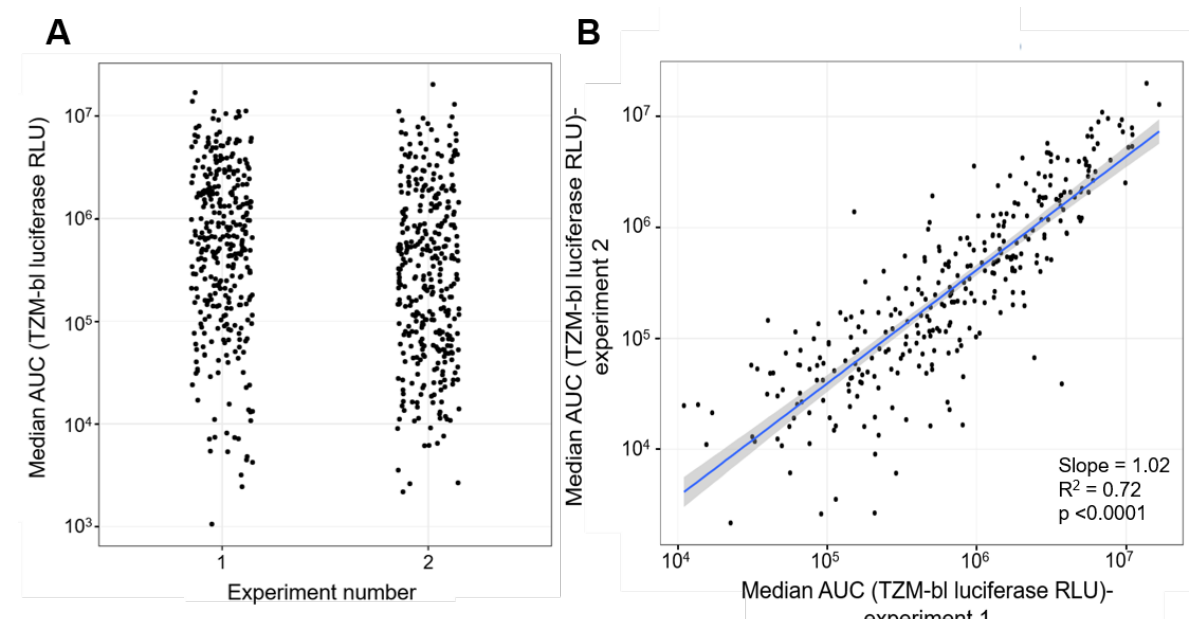
Figure 4. Comparison of replication capacities of 346 primary HIV-1 isolate obtained from two separate experiments. ( A ) Distribution of the replication capacities (AUC) of 346 primary HIV-1 isolates for each experiment. The x-axis denotes the experiment from which the AUC values were measured. The y-axis depicts the replication capacities of the primary HIV- 1 isolates represented as AUC values. ( B ) Scatterplot comparison of AUC values obtained from two separate experiments. The x-axis represents the values for the first experiment and the y-axis represent the values for the second experiment. Both axes are in log scale. An OLS regression line is shown (blue line) with its standard error band (gray shaded area).